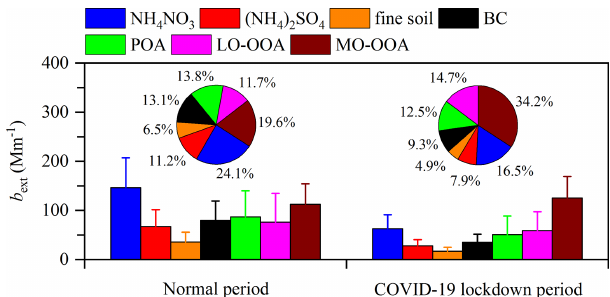
Figure 4. Contributions of NH 4 NO 3 , (NH 4 ) 2 SO 4 , fine soil, BC, POA, LO-OOA, and MO-OOA to the reconstructed chemical light extinction coefficient ( b ext ) during the normal and COVID-19 lock- down